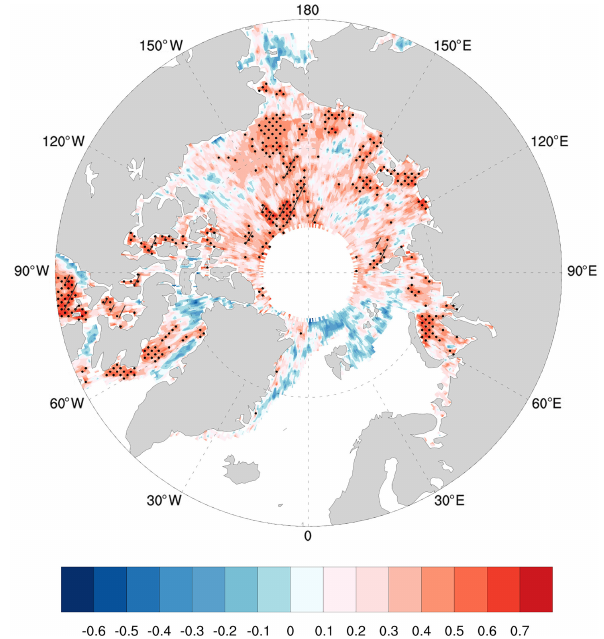
Figure 3. The spatial distribution of correlations between linearly detrended first ROS event date (FRD) from ERA-I and early melt onset date (EMO) over 1980–2017. Regions where the correlation coefficients pass the 95% confidence level ( p< 0 . 05) are denoted by black dots. Regions where the FRD comes after EMO are also denoted by a